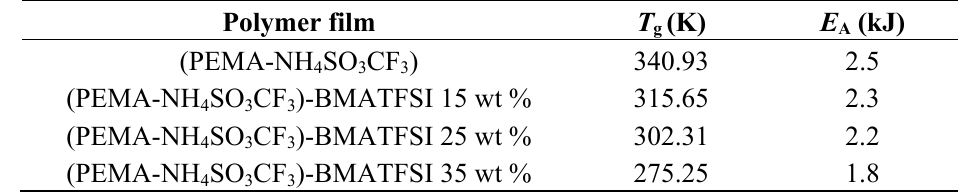
SO CF -BMATFSI polymer electrolyte films. 4 3 3